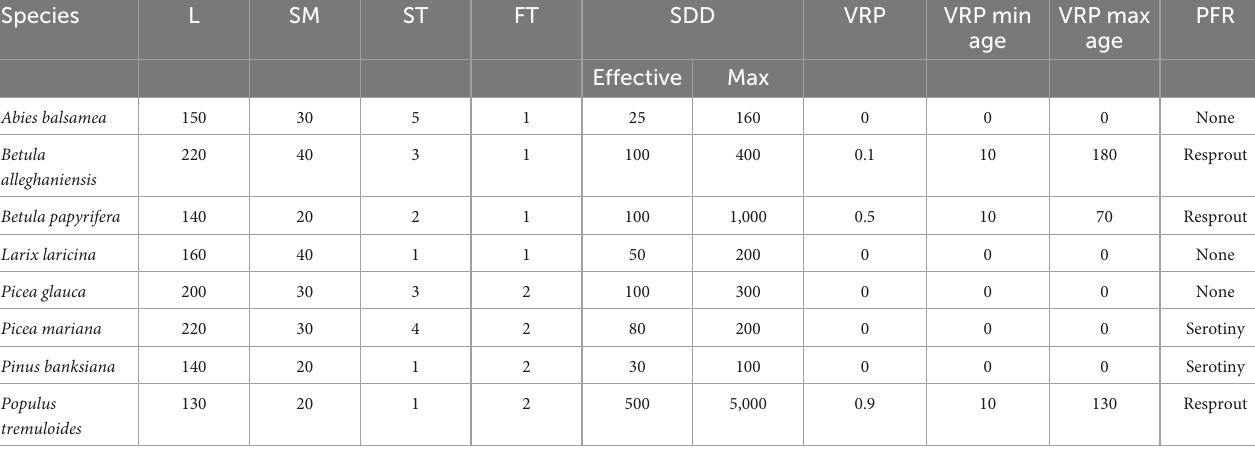
TABLE 1 The life-history attributes for the eight species according to Boulanger et al. (2017), the ages were updated considering site index per species from Pothier and Savard (1998) yield tables. Species